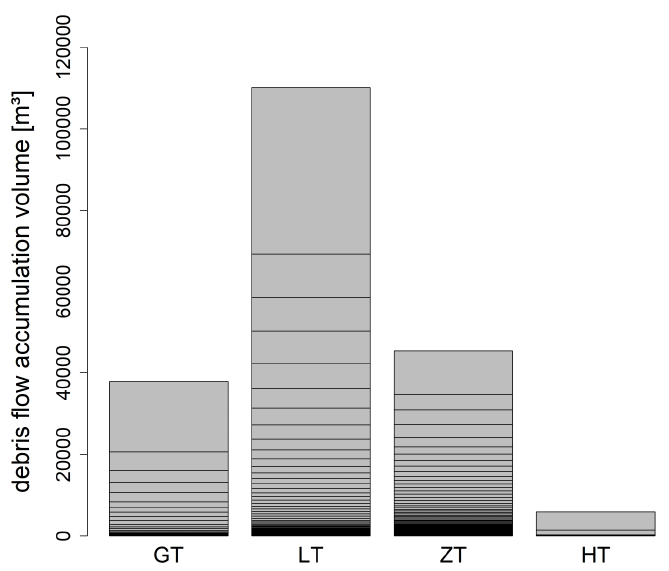
Figure 12. Debris flow accumulation volumes separated between the sub-catchments. Each single debris flow is represented by a rectangle with a size according to the accumulation volume.